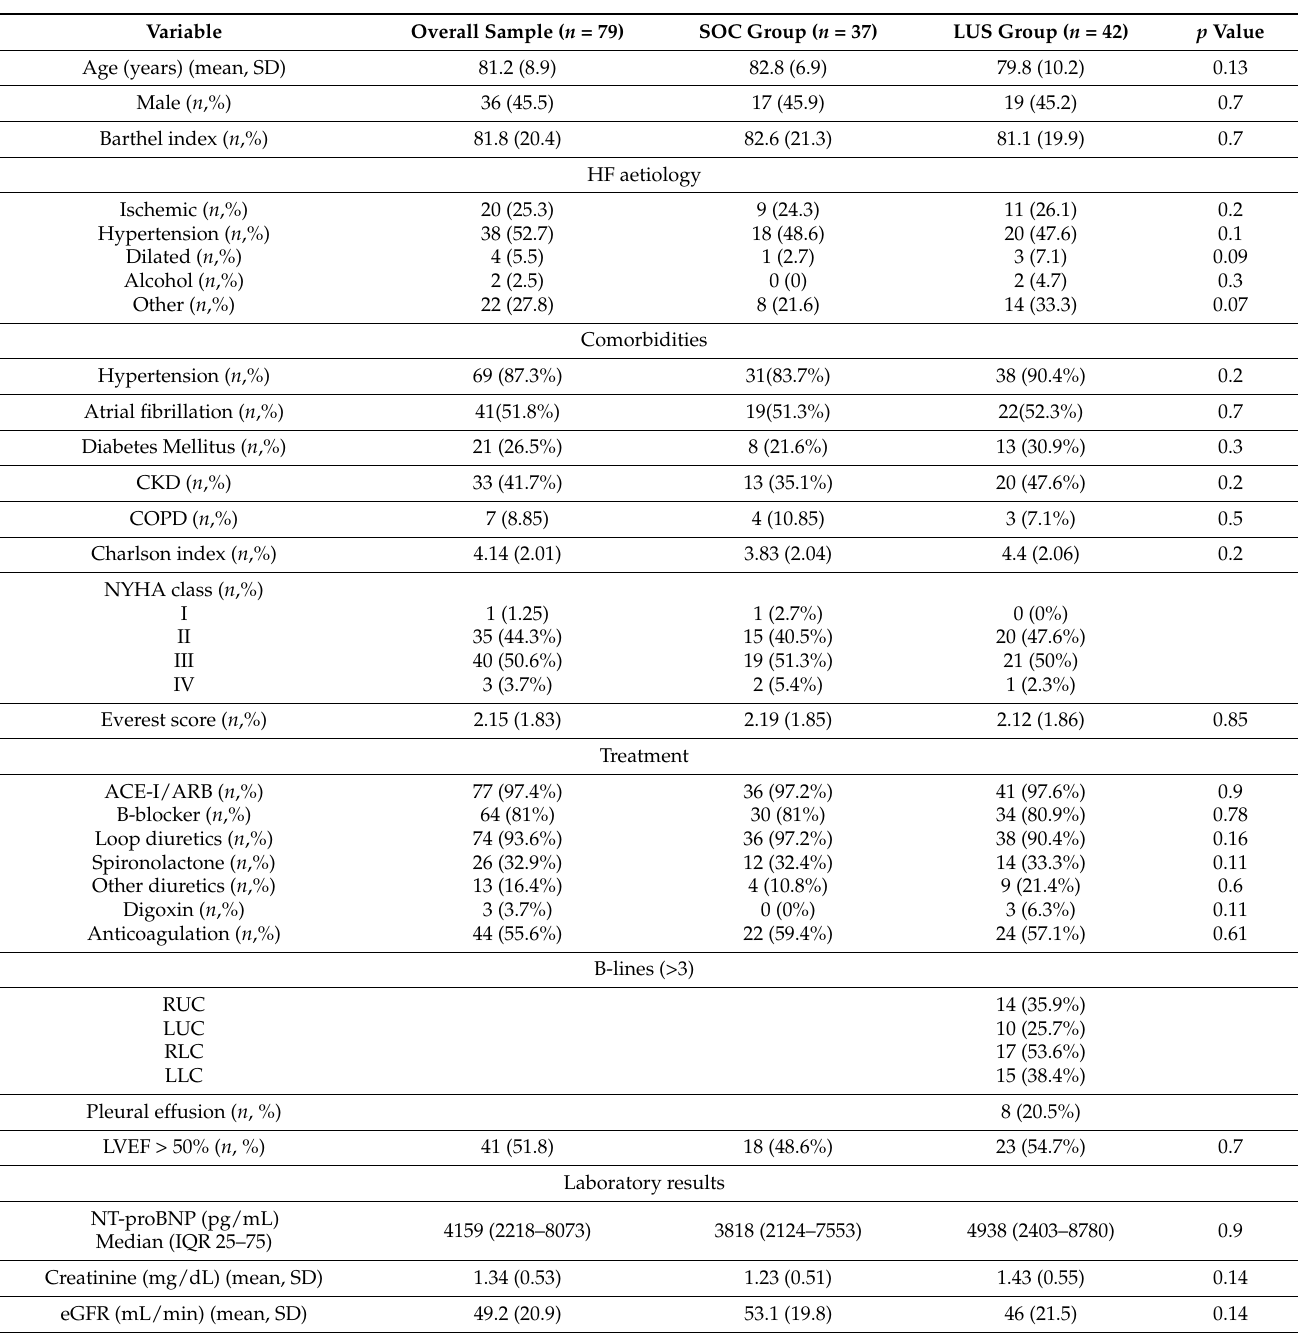
Table 1. Baseline clinical characteristics, medical treatments and LUS examination